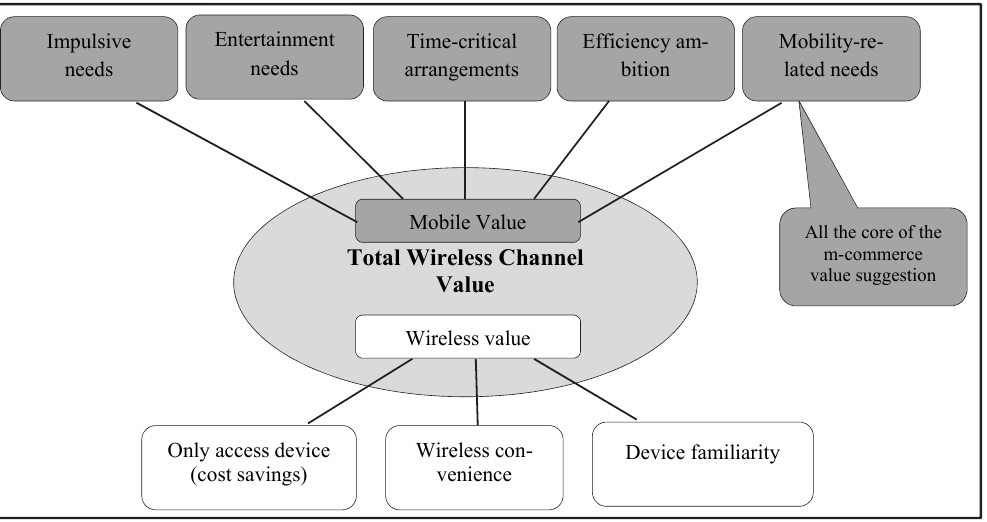
Fig. 2. Mobile commerce value elements (adapted from Anckar & d'Incau,